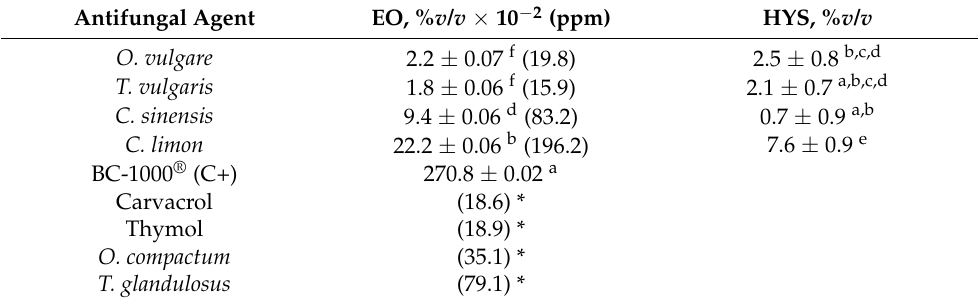
were performed three days after